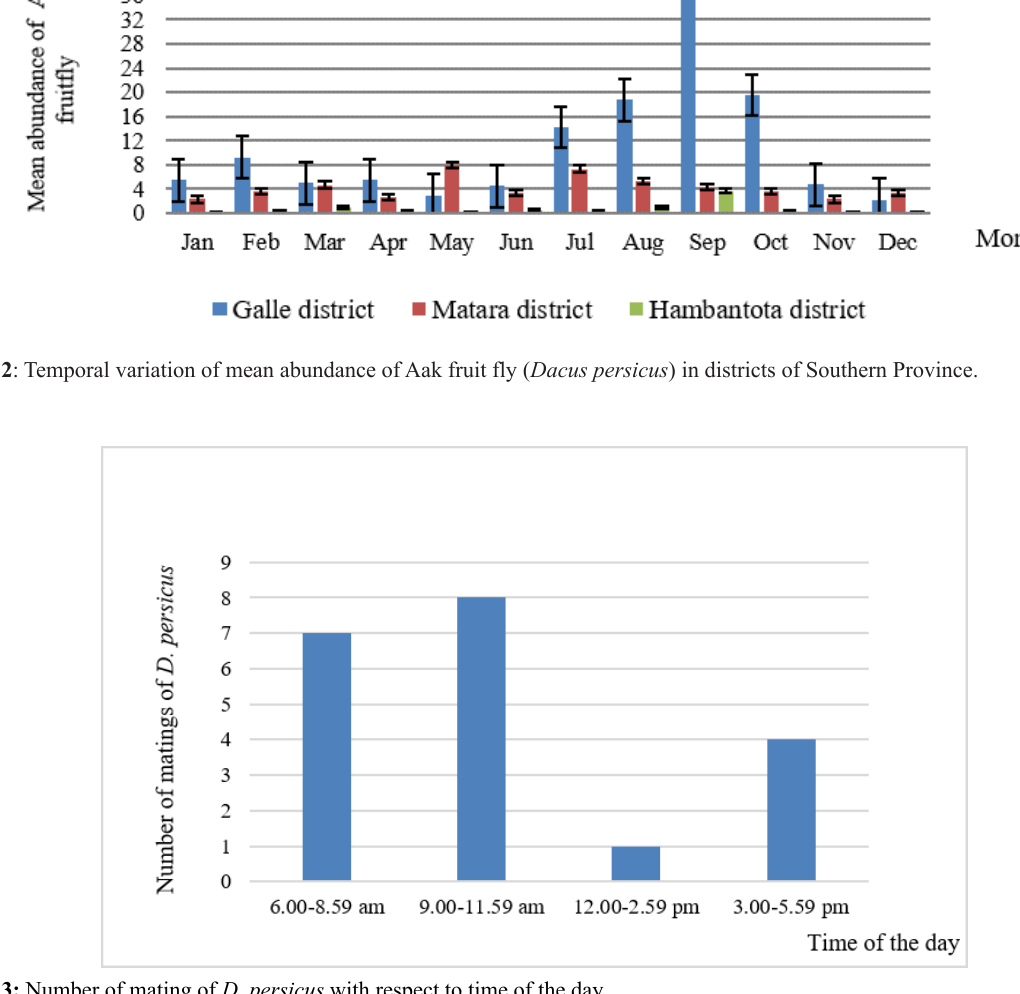
Figure 3: Number of mating of D. persicus with respect to time of the